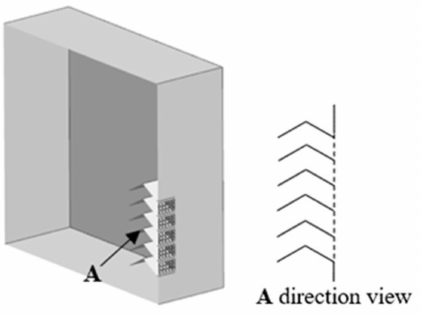
Figure 13. The 120 ◦ diaphragm structure diagram.